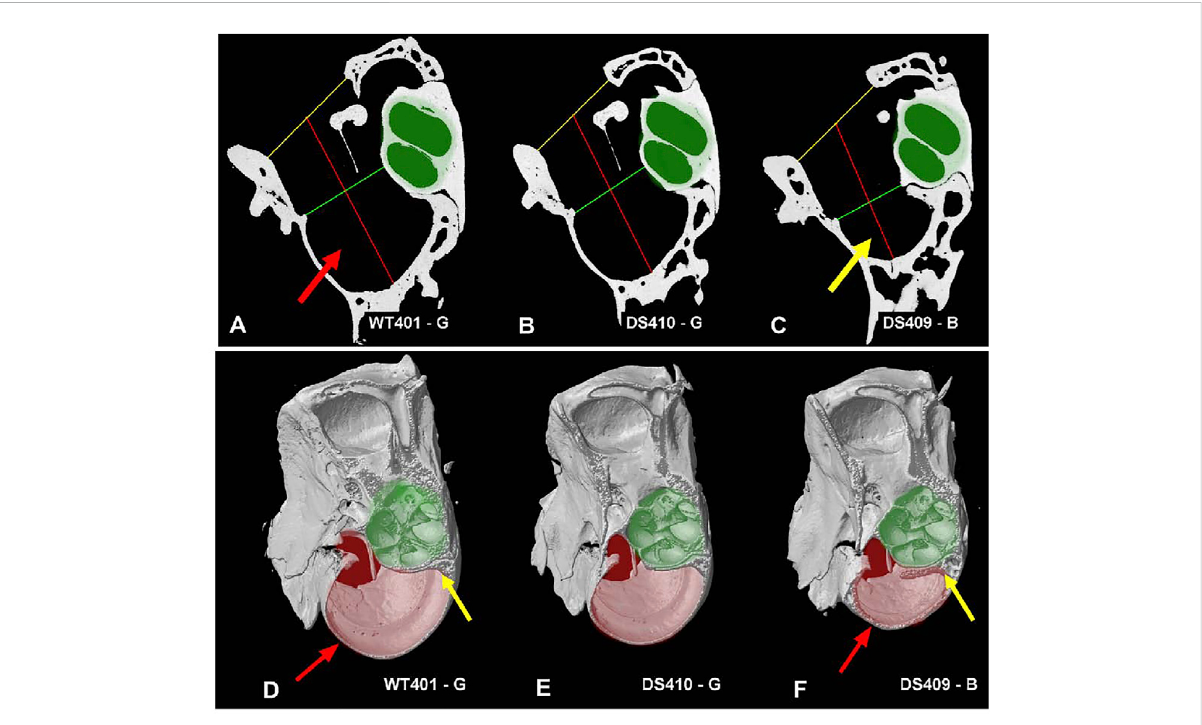
FIGURE 10 Figure illustrating tympanic cavity measurements and tympanic cavity wall thickness. Image showing measurements taken for the tympanic cavity of a (A) WT mouse, (B) a DS mouse with relatively normal ABR thresholds and (C) a DS mouse with greatly elevated ABR thresholds. Measurements for the tympanic membrane opening width (yellow line) and mid-tympanic cavity width (green line) were taken across the shortest distance at their respective locations. The tympanic cavity depth (red line) was taken passing through the midpoint of the two width lines. The overall dimensions of the two DS cochleae (B-C, highlighted in green) were not noticeably different from the WT mouse cochlea (A) . However, the tympaniccavity intheDSmousewithelevatedABRthresholds(C,yellowarrow)wasvisuallymuchsmallerthanthetympaniccavityintheWTmouse with normal ABR thresholds (A, red arrow) and the DS mouse with nearly normal ABR thresholds (B) . (D – F) Tympanic cavity wall was often thicker in DSmicewithelevatedABRthresholdsthanWTmice. (D) WTmousewithnormalABRthresholds,thin-walledtemporalbonecapsule(redarrow),and thin layer of bone around cochlea (yellow line). (E) DS mouse with relatively normal ABR thresholds had thin-walled temporal bone capsule and thin layerofbonearoundcochlea. (F) DSmousewithgreatlyelevatedABRthresholdshadthick-walledtemporalbonecapsule(redarrow)andthickbone around the cochlea (yellow line). The tympanic cavity (pale-red highlight) is notably smaller in the (F) DS mouse with greatly elevated thresholds compared to (D) WT mouse with normal ABR thresholds and (E) DS mouse with nearly normal ABR thresholds. Cochlea (pale-green highlight) approximately the same size in (D) WT and (E,F) two DS mice.